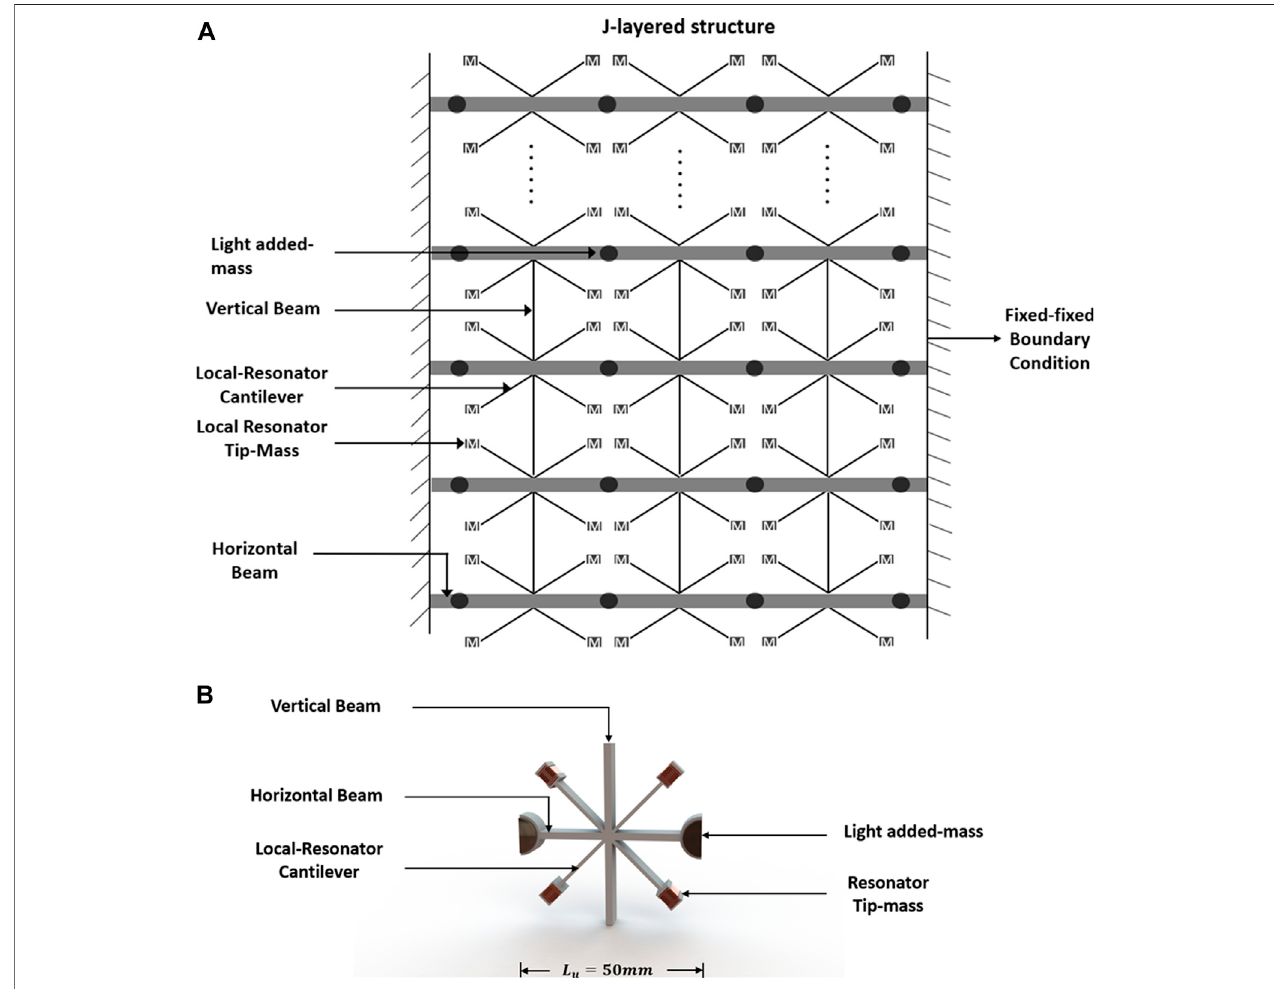
FIGURE1| Schematic description ofaj-layered metamaterialstructureand its coupled parts: (A) Layeredmetamaterial structure constituents including horizontal beams,verticalbeamsandlocalresonators,and (B) Representationofthebasicunitcellofthelayeredmetamaterialassembly.Itiscomprisedoflocalresonatorswithtip masses and vertical columns attached to the beam. The length of a unit cell is 50